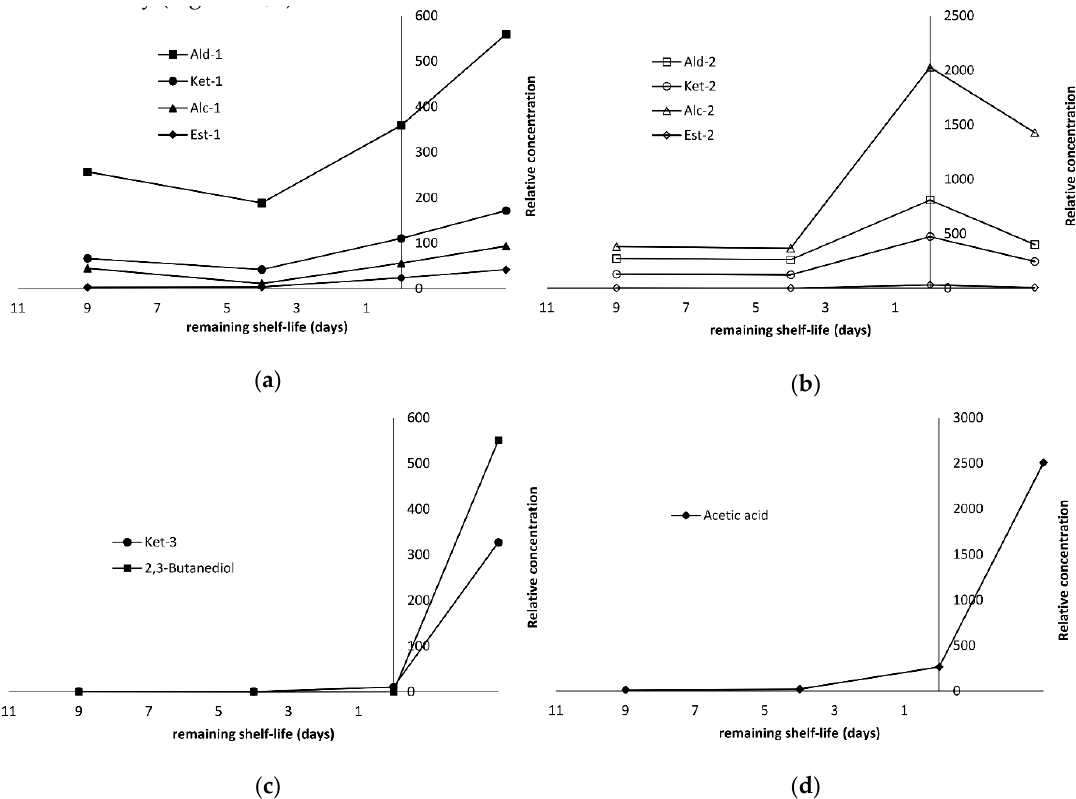
Figure 4. Changes of volatiles in relation to the remaining shelf life during storage of sea bass fillets under MAP at 2 °C: ( a ) Group Ald-1, Ket-1, Alc-1 and Est-1; ( b ) Group Ald-2, Ket-2, Alc-2 and Est-2; ( c ) Group Ket-3 and 2,3-butanediol; ( d ) Acetic acid. The compounds included in each group are described in Table 1.